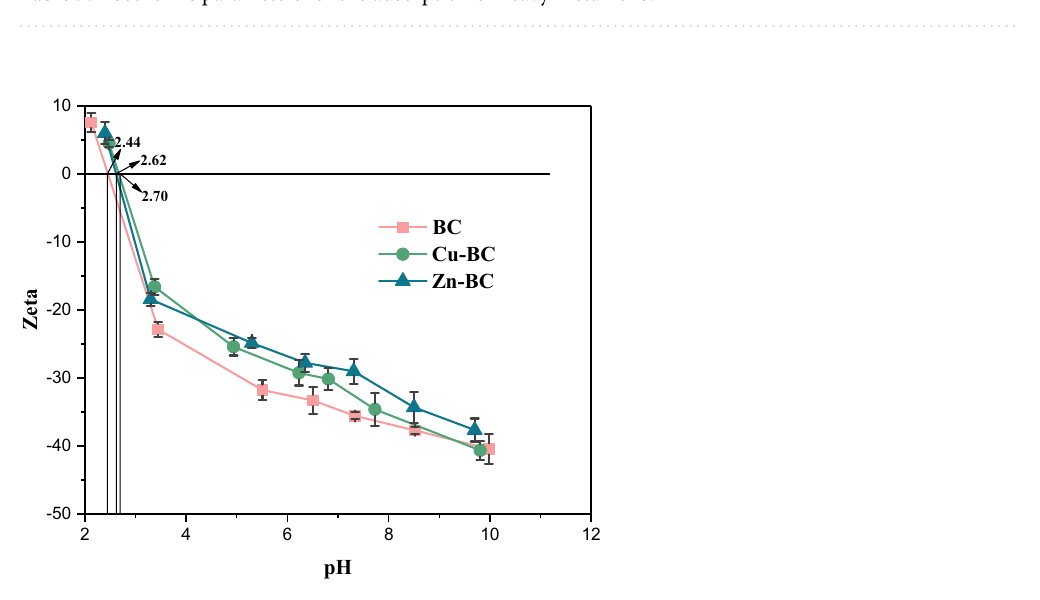
Figure 7. Zeta potential of BC, Cu-BC and